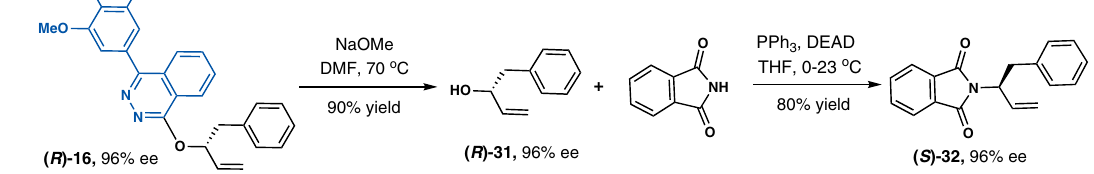
Fig. 6 Synthetic application. DEAD: